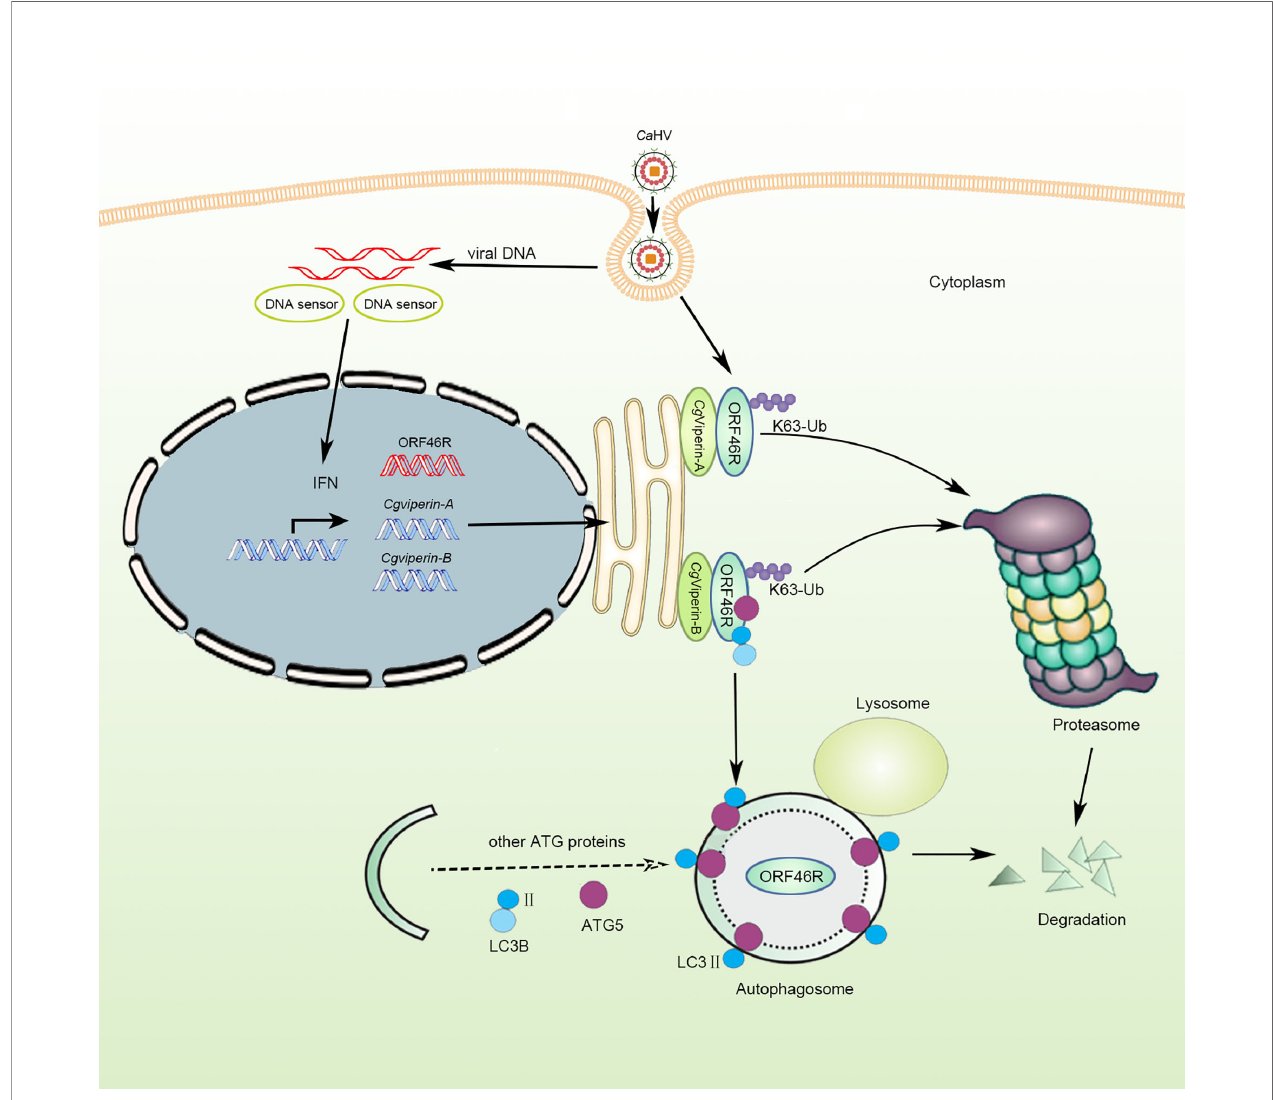
FIGURE 9 | Schematic diagram of divergent antiviral mechanisms of Cg Viperin-A and Cg Viperin-B in gibel carp resistance against herpesvirus Ca HV. Both Cg Viperin-A and Cg Viperin-B directly interact and promote proteasomal degradation of Ca HV ORF46R via decreasing K63-linked ubiquitination. In addition, Cg Viperin-B induces ORF46R degradation through autophagosome